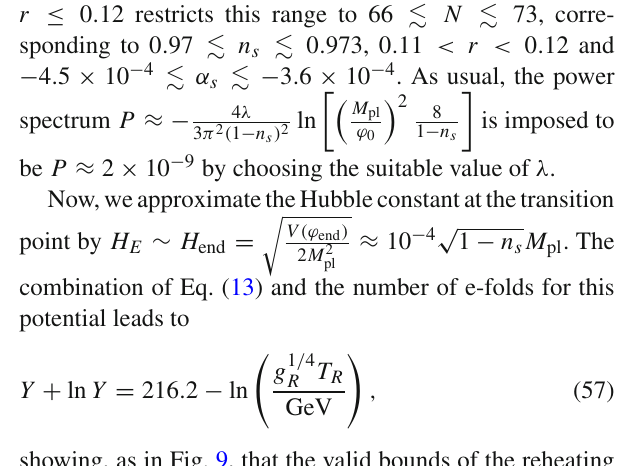
Fig. 8 Phase portrait in the plane (ϕ/ M pl , ˙ ϕ/ M 2 of the time t × M pl (right) for the same orbits represented in the phase